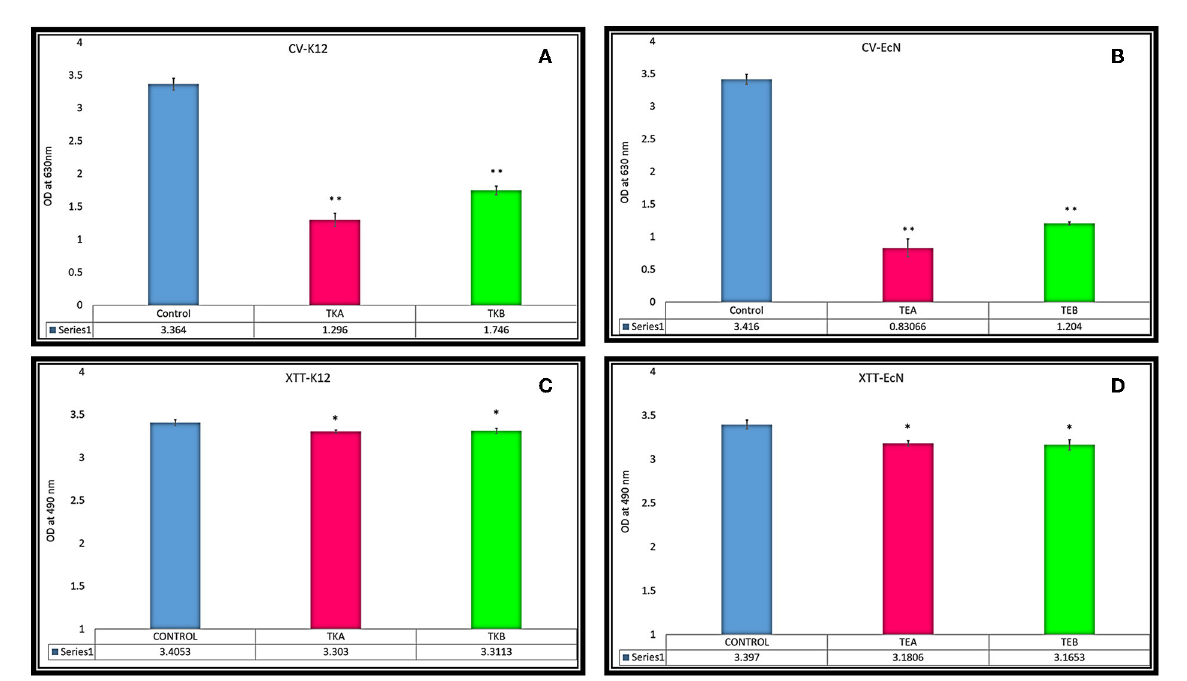
FIGURE2 (A,B) Biofilm reduction quantification was done through CV assay in csgD -KD cells. (A) TKA showed 61.47% and TKB 48.09% biofilm reduction, respectively, compared to the control cells. (B) The EcN csgD -KD mutants TEA and TEB showed 75.6% and 64.7% biofilm reduction. (C,D) XTT reduction assay for cell viability in csgD csgD -KD cells. (C) Cell viability of csgD -KD cells of K12 (TKA and TKB) (D) Cell viability of csgD -KD cells of EcN (TEA and TEB). The data shown here represent an average value of triplicate experiments ± S ( * P < 0.05, t -test, two-sided), ( ** P < 0.005, t -test,